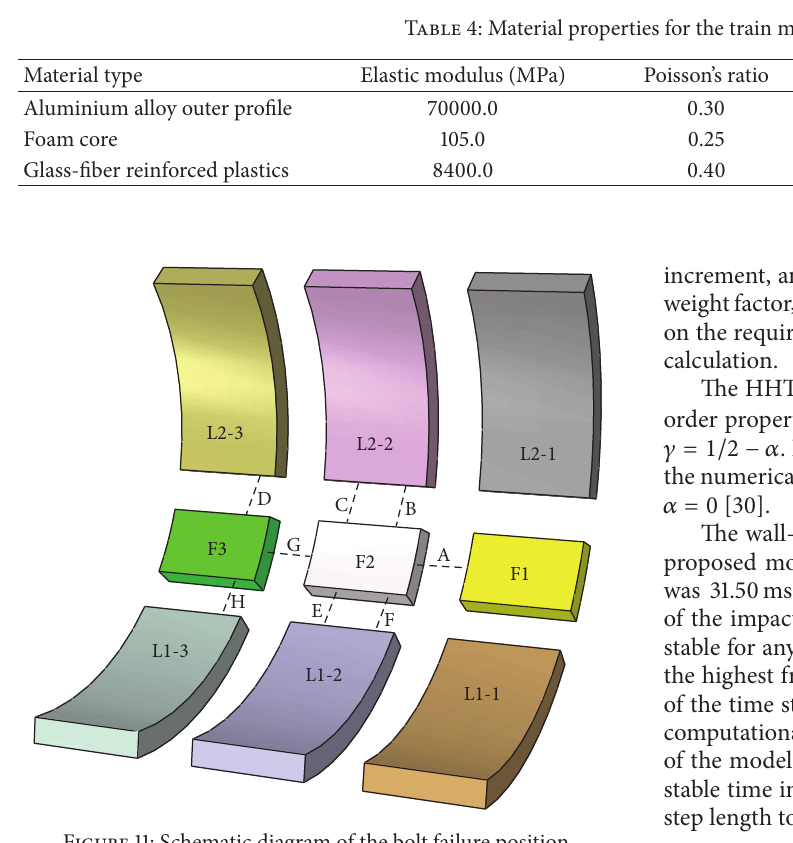
proposed FE model of the shield tunnel, and the numerical results are provided in the following section. In particular, the failure characteristics of the joint bolts are carefully discussed in terms of the failure location and the failure